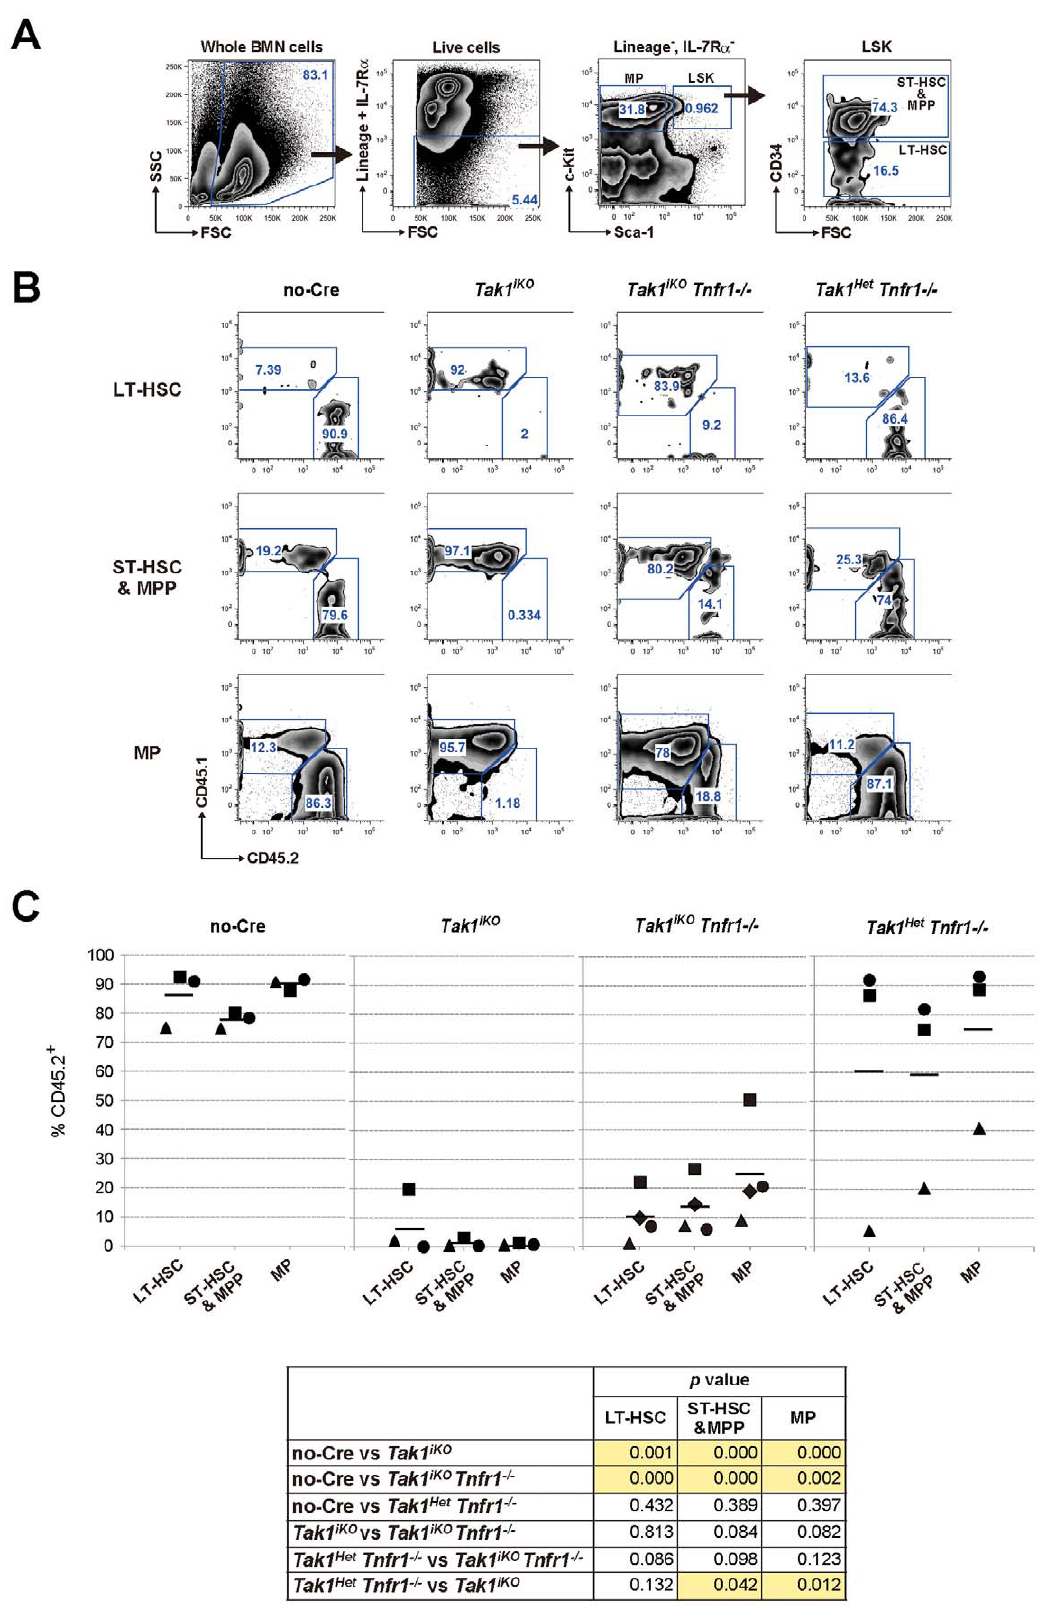
Figure 6. Impaired LT-HSC function by Tak1 deficiency cannot be rescued by ablation of TNF signaling. (A) Gating strategy for LT-HSC, ST-HSC/MPP and MP in the competitive reconstitution assay. (B) Representative results of chimerism analysis of No-Cre, Tak1 iKO , Tak1 iKO Tnfr1 2 / 2 , and